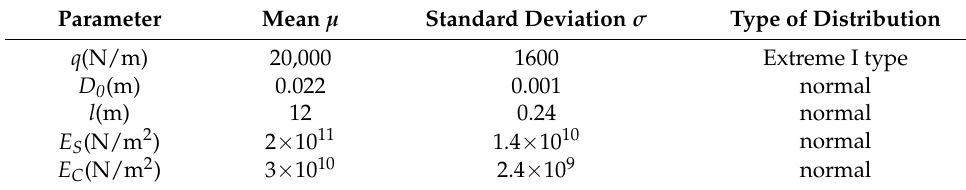
Table 6. Distribution of random variables of the roof truss